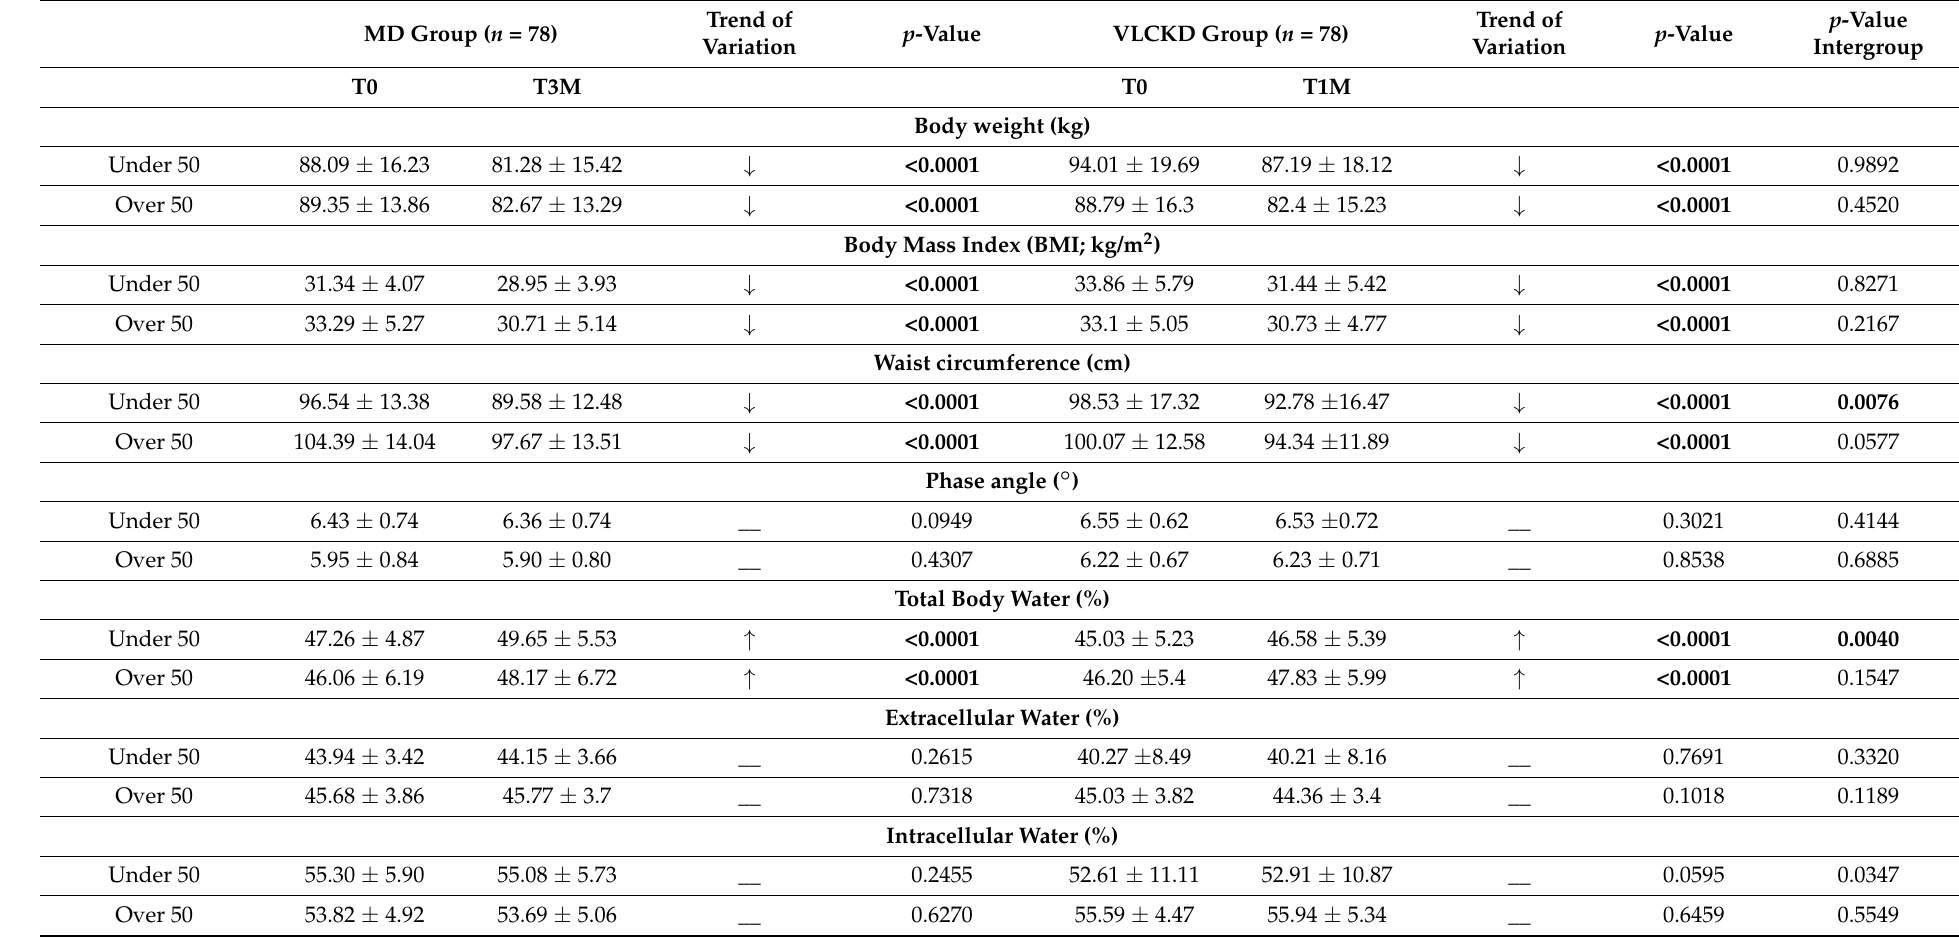
Table 2. Anthropometric and Body composition changes in MD and VLCKD groups according to age (mean ±